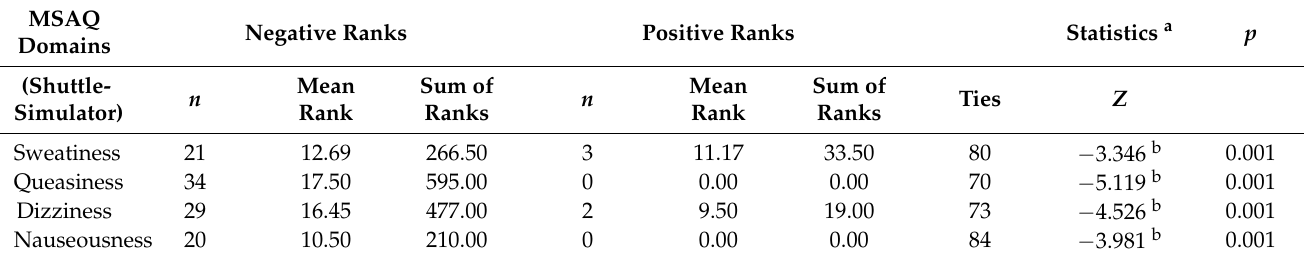
Table 2. Motion and Simulator Sickness Differences between Automated Shuttle and Driving Simulator Exposures ( n = 104). MSAQ Negative Ranks Positive Ranks Statistics a Domains (Shuttle- Simulator) Queasiness